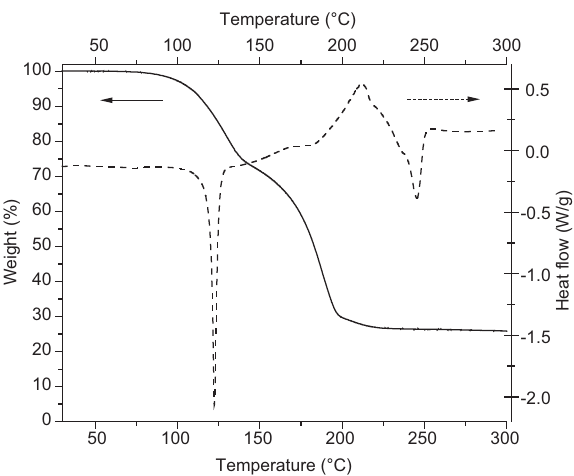
Figure 1 DSC and TGA thermograms of a pure [Ag(hfac)(COD)] sample.